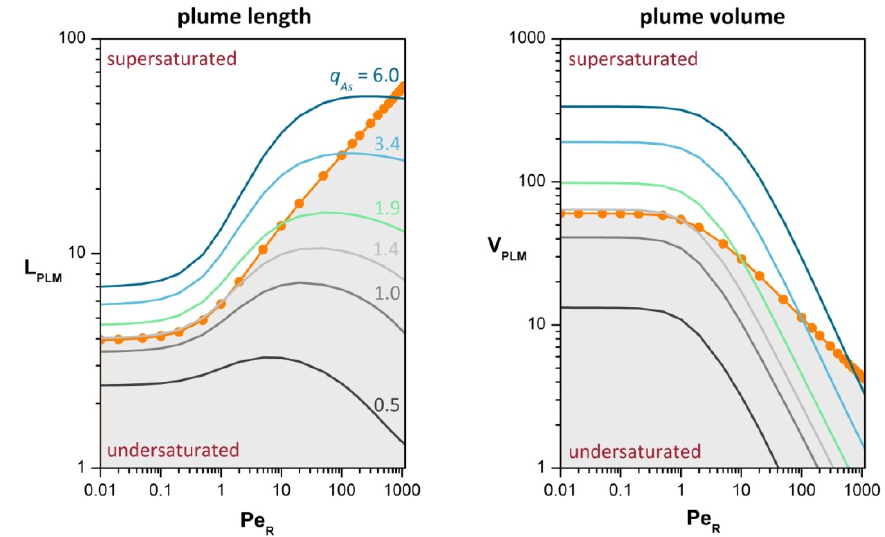
Figure 7. Effects of controlled release on the length ( L plm ) and volume ( V plm ) of the eutrophic plume around a nutrient-releasing particle. Higher release rate ( q As ) represents elevated activities of particle-associated bacteria. The orange line with filled circles corresponds to transport-limited dissolution and represents the uncoupled hydrolysis concept set forth by Azam and coworkers [6,25,39], in which the enzymatic capacity significantly exceeds intraparticle uptake and leakage to ambient water. The orange line also delimits the domains of supersaturated ( C As > 1) and undersaturated particles ( C As < 1). Plume metrics were calculated for Da = 0.1 and C det = 0.1 in all cases. The reference state ( q As = 1 ) corresponds to a saturated particle in equilibrium with the surrounding water ( Pe = 0, Da = 0